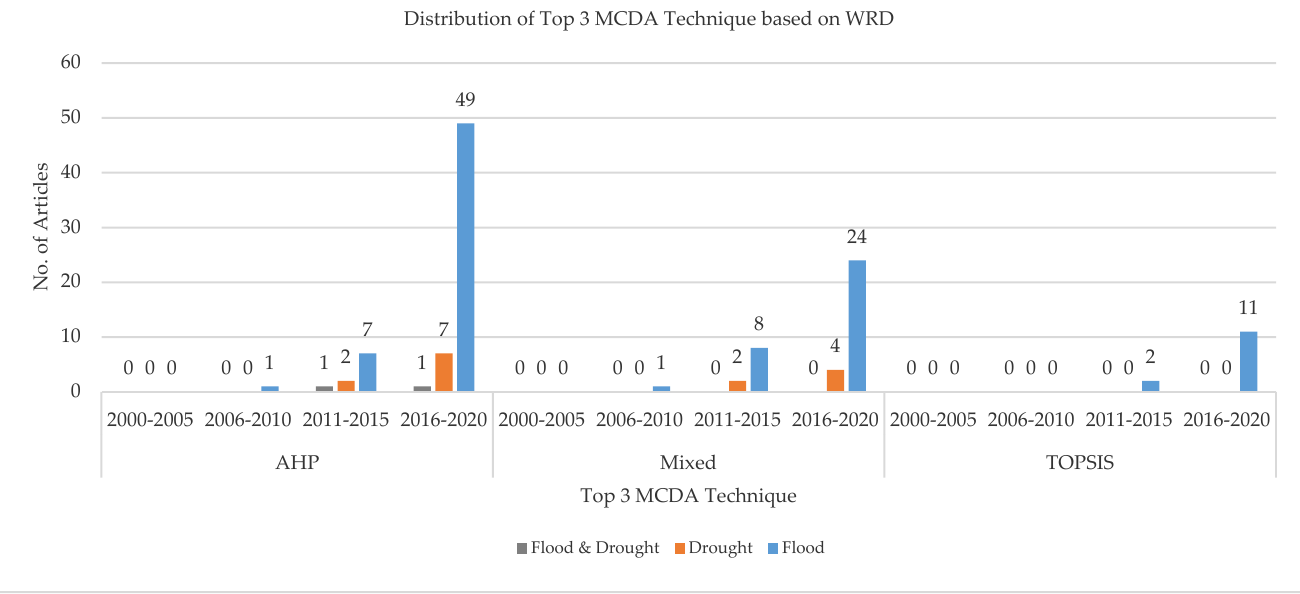
Figure 5. Distribution of top three MCDA techniques based on WRD.